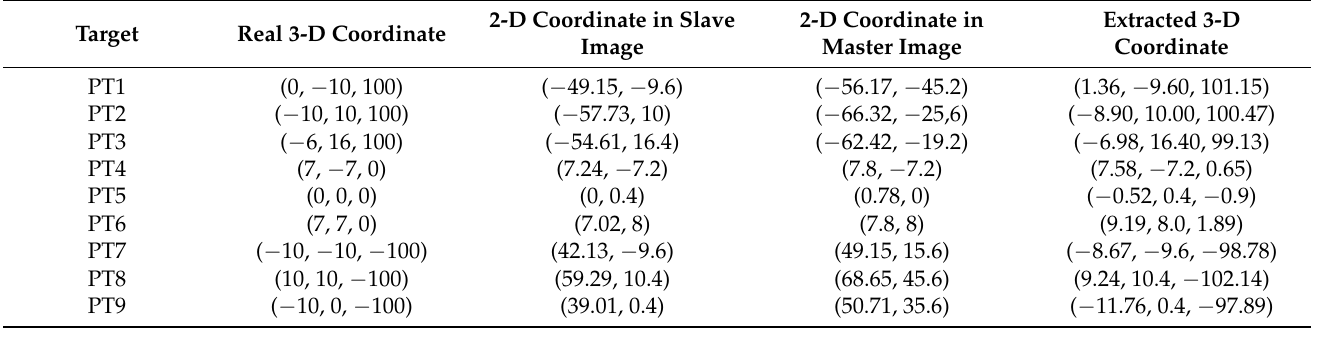
Figure 10. Result after image pair registration.